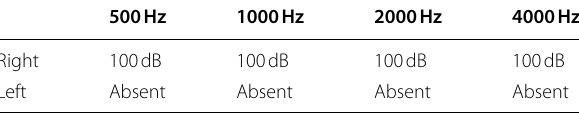
Table 2 Results of the ipsilateral acoustic reflex, November